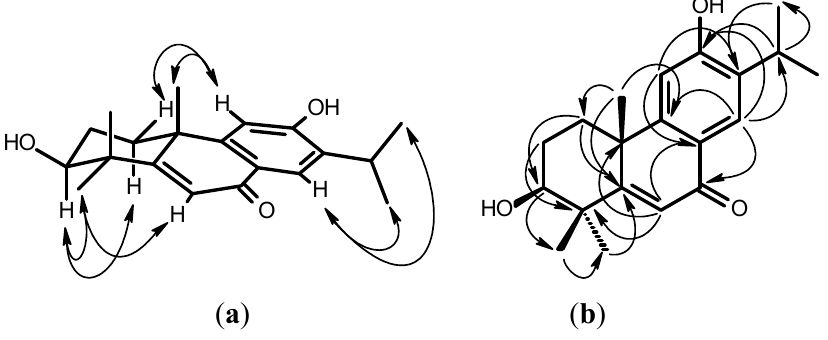
Figure 3. Key NOESY contacts ( a ) and HMBC connectivities ( b ) of compound 2